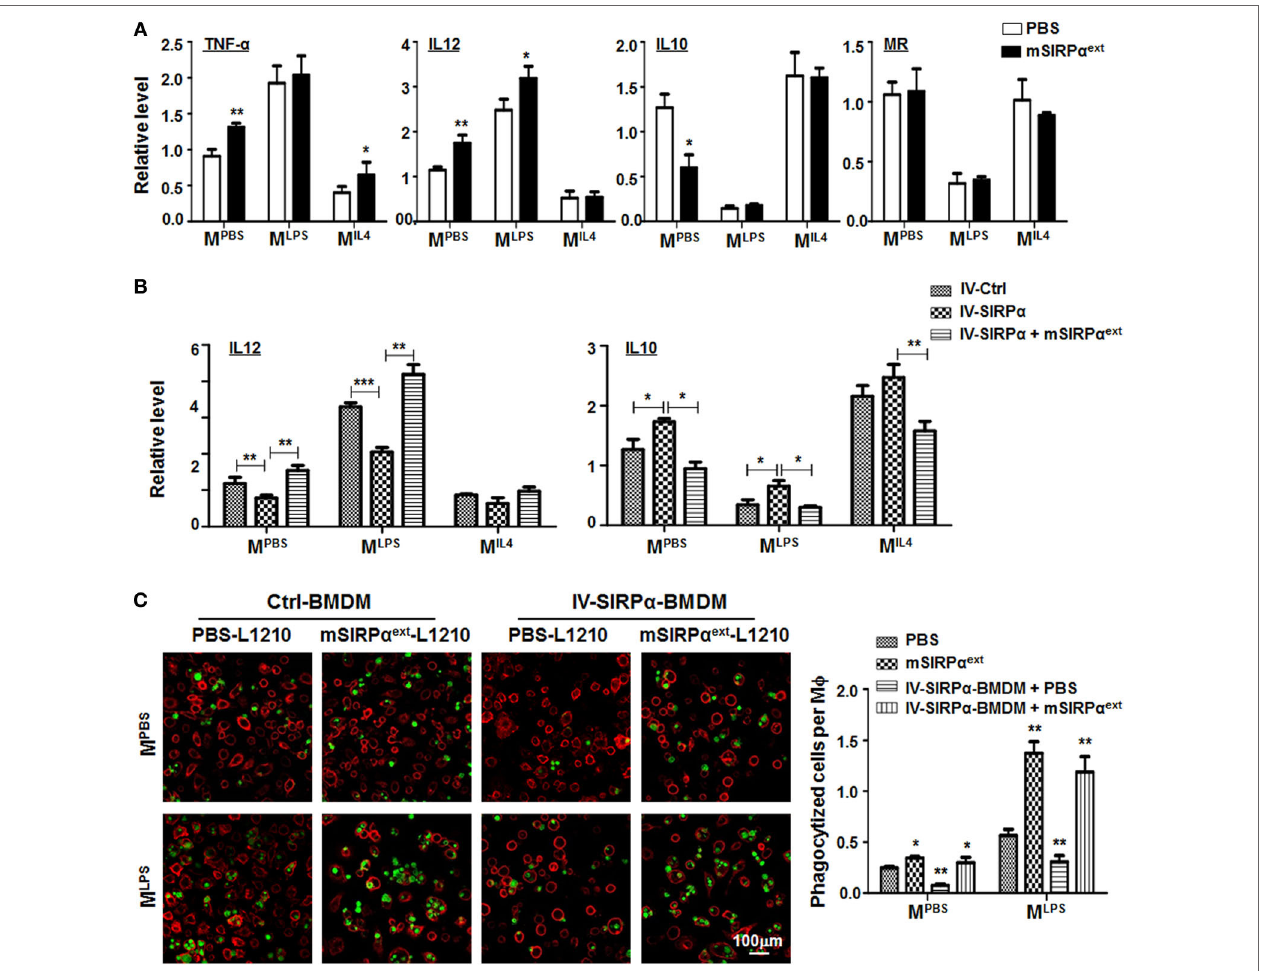
FigUre 7 | Recombinant mSIRP α ext promoted M1 polarization and enhanced phagocytosis of M1 macrophages in vitro . (a) Differentially polarized bone marrow- derived macrophages (BMDMs) were incubated with PBS or mSIRP α ext for 6 h. The expression of TNF- α , IL12, IL10, and MR was determined by qRT-polymerase chain reaction (PCR) ( n = 3). (B) BMDMs overexpressing SIRP α were incubated with mSIRP α ext for competitive interaction and stimulated with PBS or lipopolysaccharide